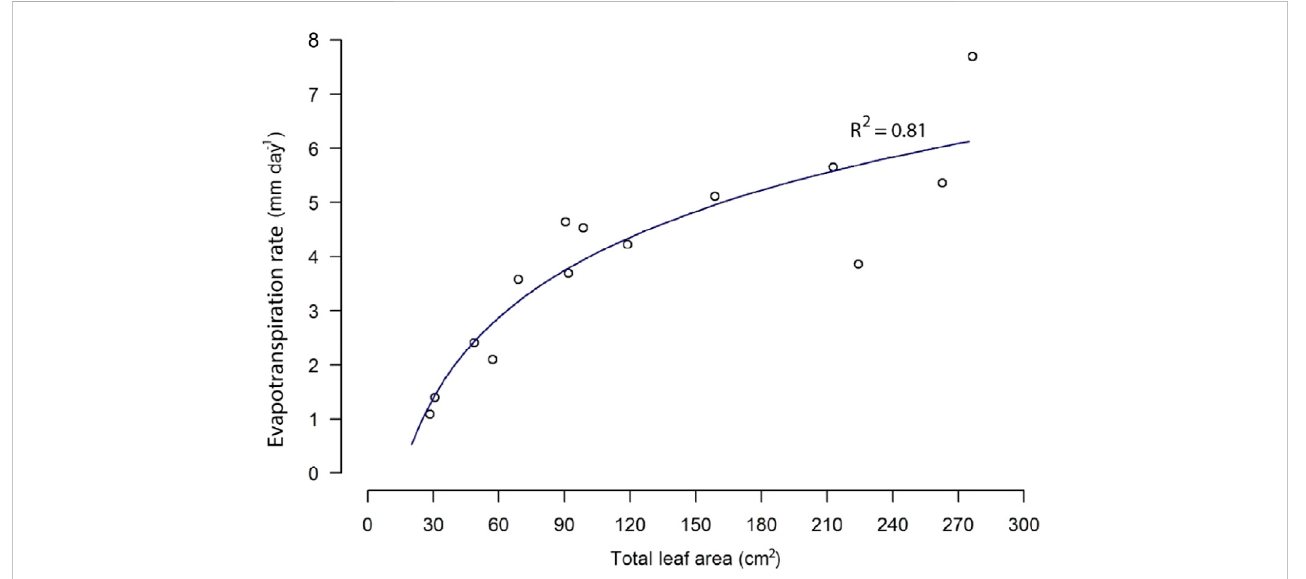
FIGURE 4 Evapotranspiration (mm day − 1 ) as a function of total leaf area (cm 2 ) in the vegetated column. Transpiration was measured with the LI-COIR photosynthesis